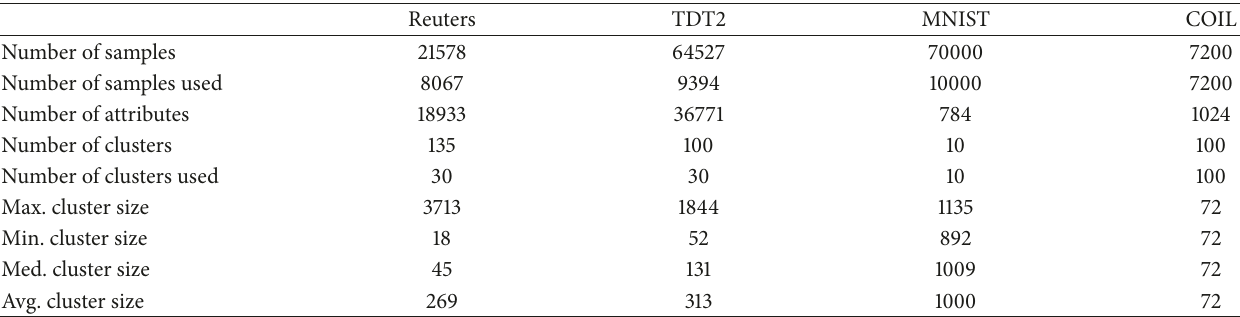
Table 1: Statistics of benchmark datasets.